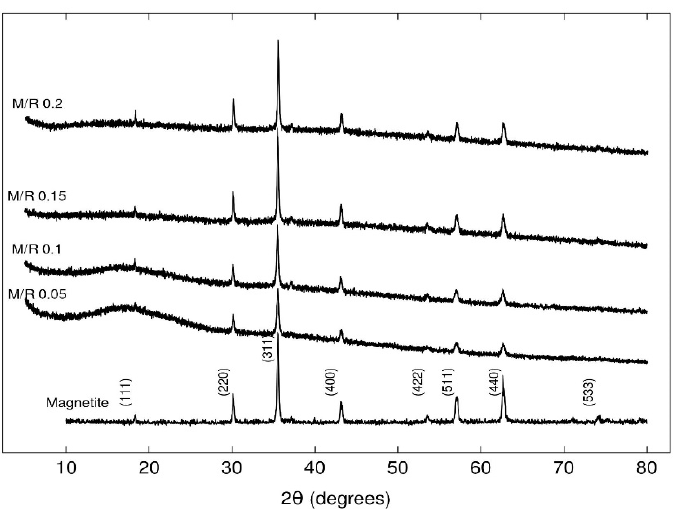
Figure 2. X-ray diffraction patterns of magnetic xerogel monoliths with different molar ratios of M/R.